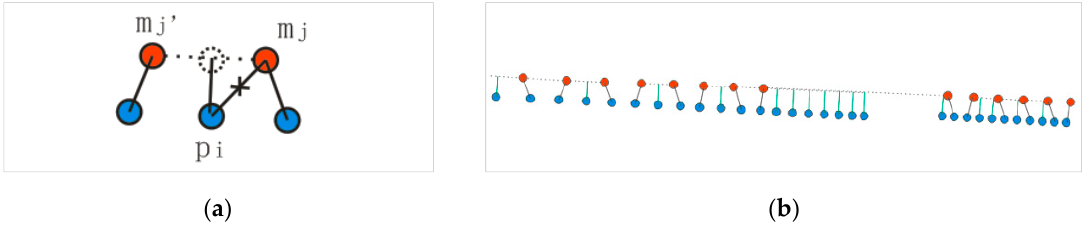
Figure 7 . ( a ) Interpolation process (red dots-scanned points in reference scan, blue dots-scanned points in object scan); ( b ) correspondences that were established by the new procedure (red dots-scanned points in reference scan, blue dots-scanned points in object scan).